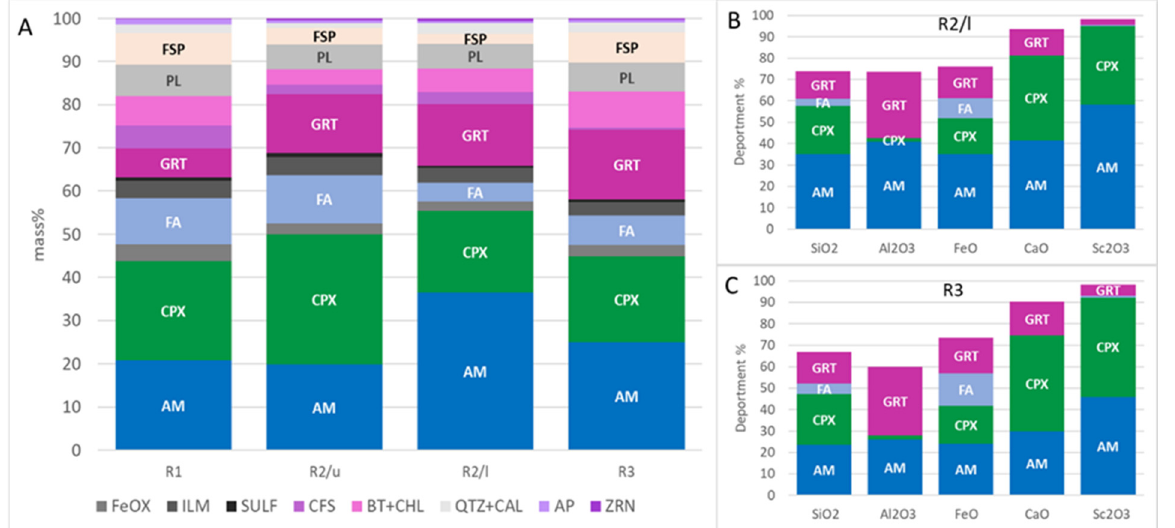
Figure 1. ( A ) Modal compositions of the concentrates used in pyrometallurgical experiments.